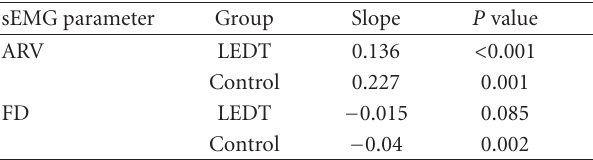
Table 1: Results of linear regression analysis for refatigue